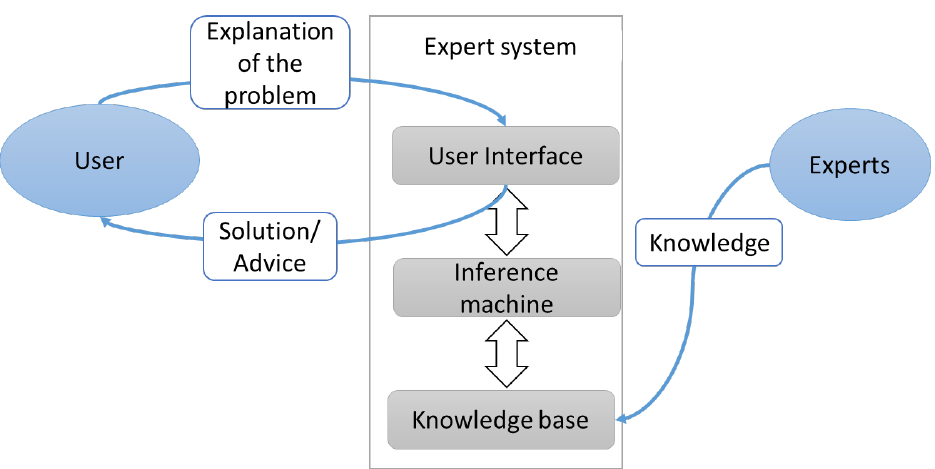
Figure 1. Architecture of expert system. Adapted from Maylawati et al. [91], and Salman and Abu-Naser [89].